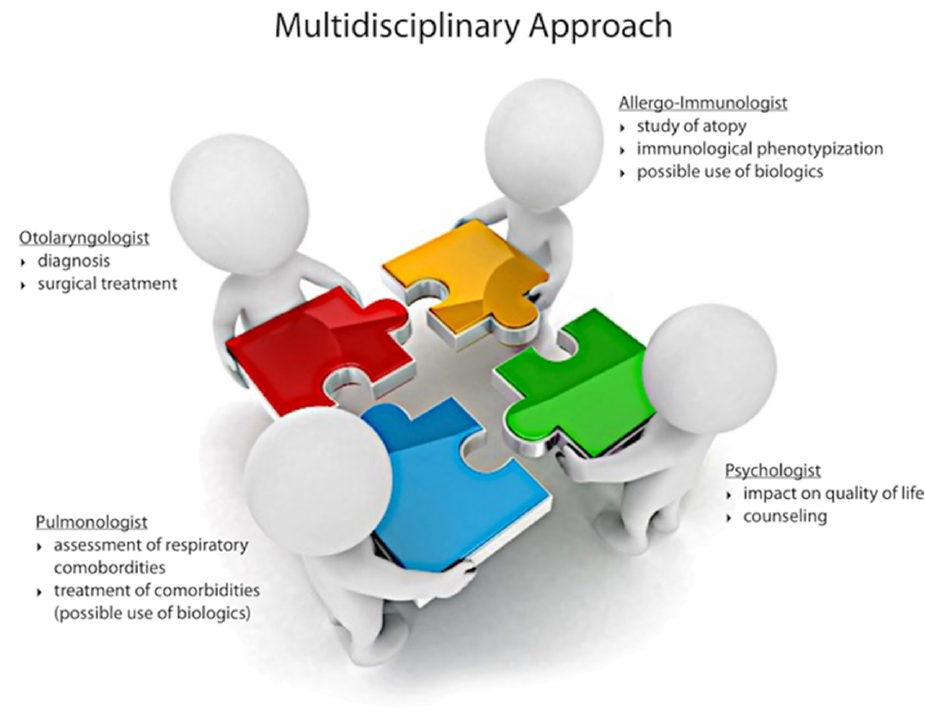
Figure 1. Multidisciplinary approach to patients with chronic rhinosinusitis.